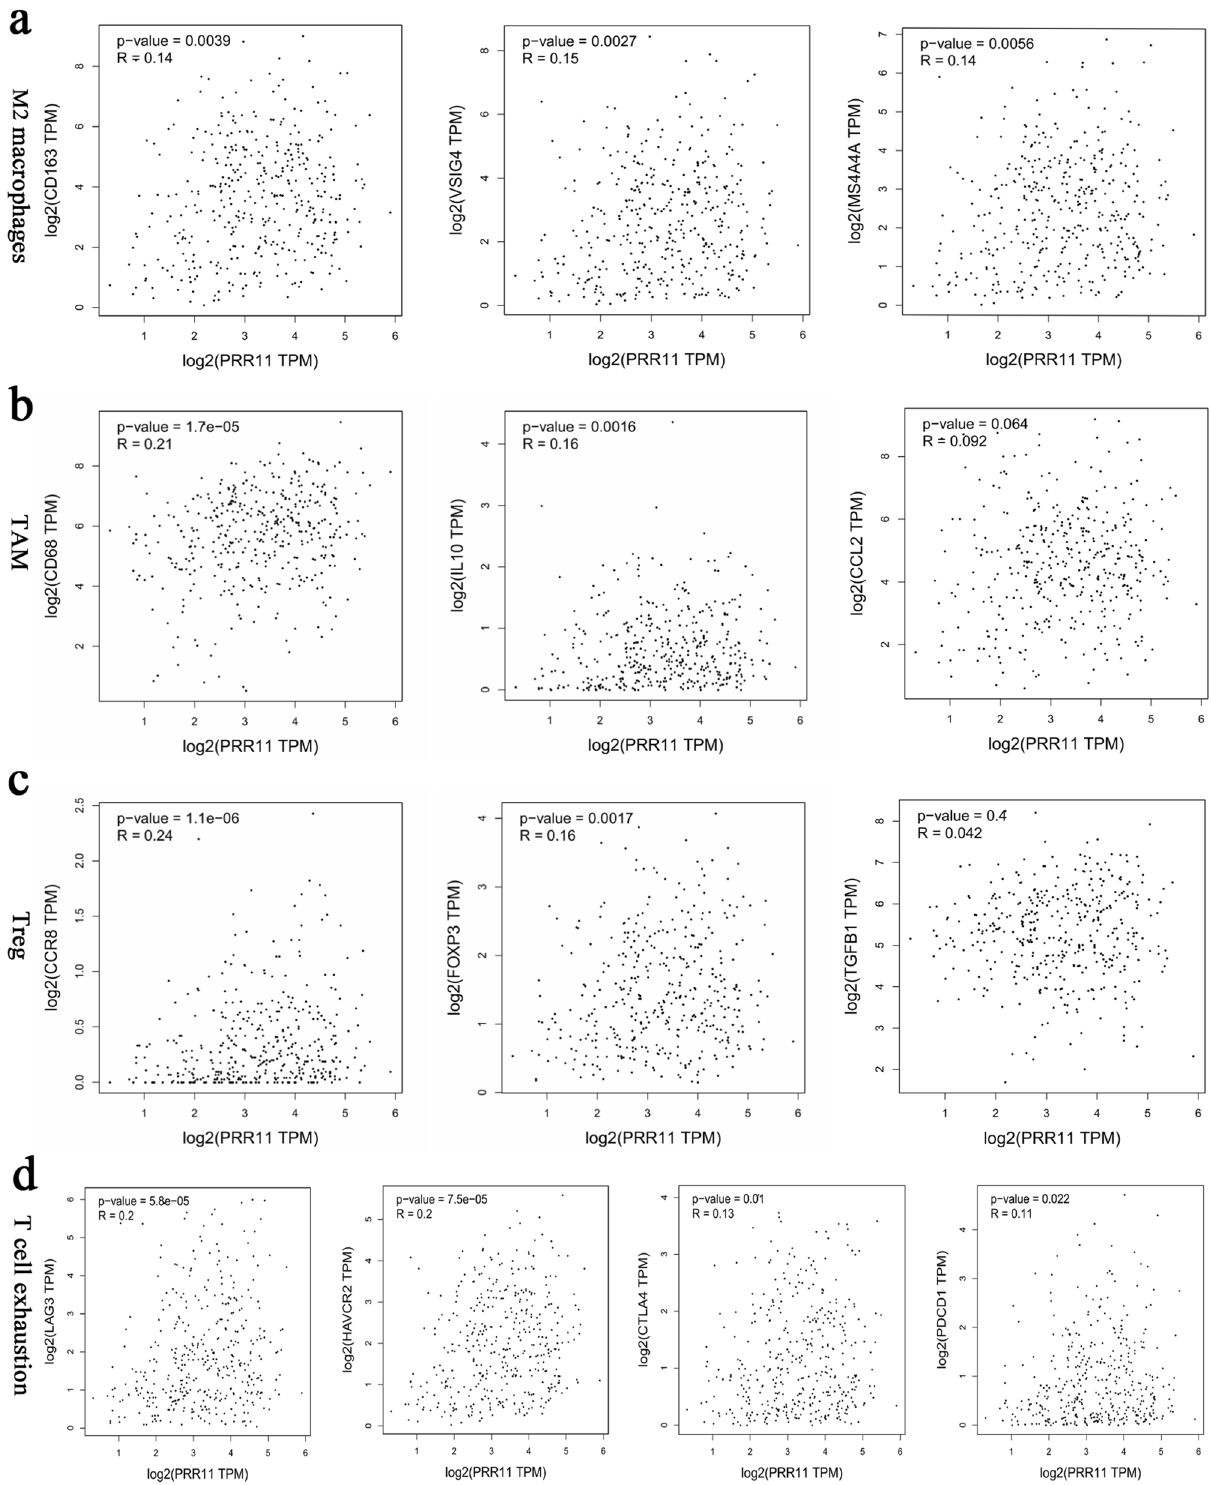
Figure 9. ( a ) Scatterplots of correlations between PRR11 expression and gene markers of M2 macrophages. ( b ) Scatterplots of correlations between PRR11 expression and gene markers of TAM. ( c ) Scatterplots of correlations between PRR11 expression and gene markers of T cell